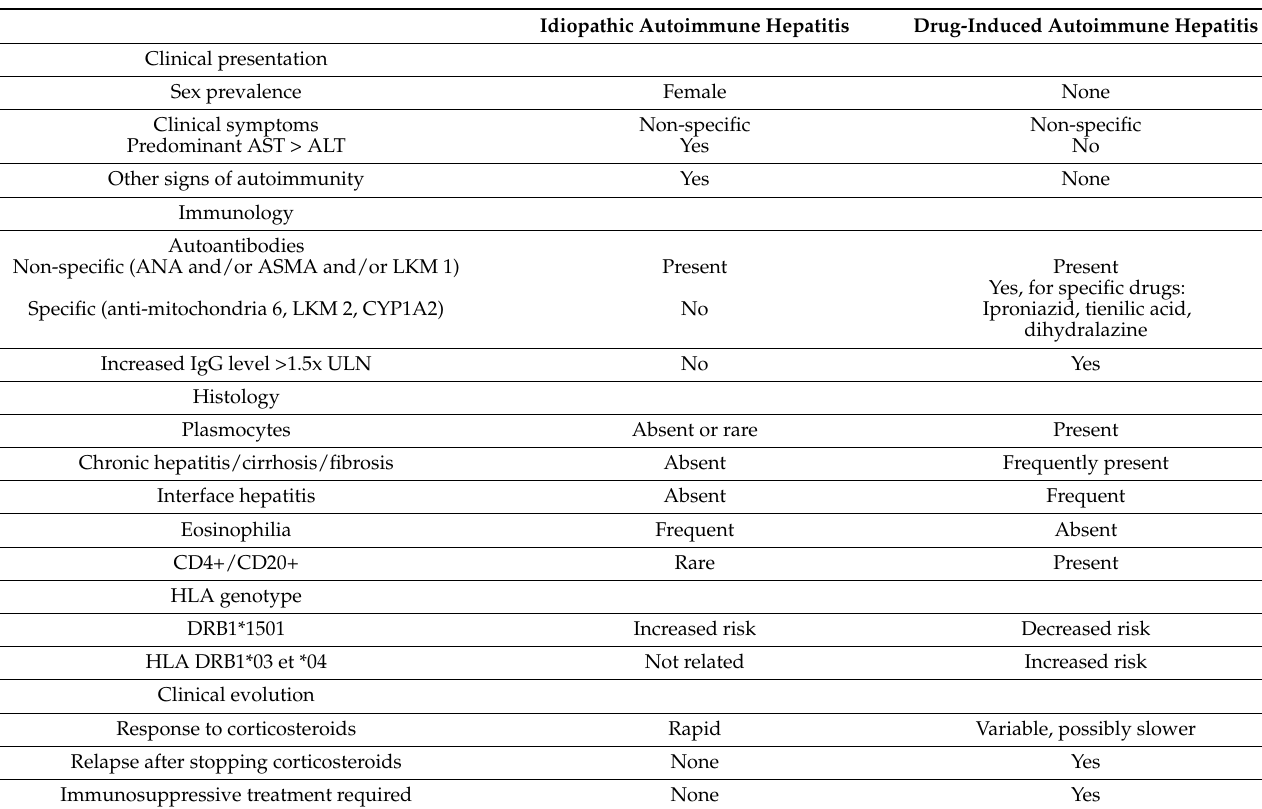
Table 3. Criteria that can contribute to the differentiation between drug-induced autoimmune hepatitis and idiopathic autoimmune hepatitis associated with MS